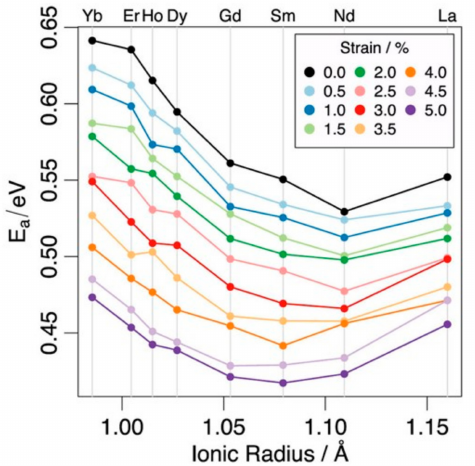
Figure 2. Molecular dynamics derived activation energies of oxygen migration with respect to the dopant ionic radius and uniaxial strain in Ce 0.9 R 0.1 O 1.95